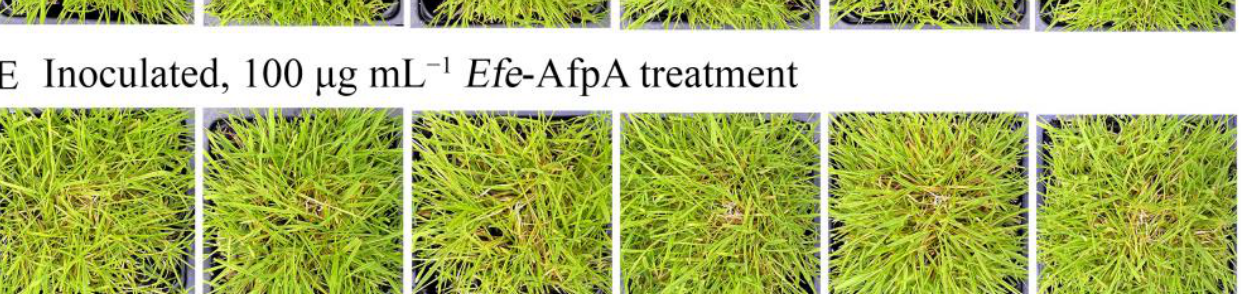
Figure 9. Effect of Efe -AfpA concentration on expression of dollar spot disease symptoms when creeping bentgrass cv. ‘Crenshaw’ plants were inoculated with an 8 mm plug of C. jacksonii . Plants were sprayed daily for 7 days with either water ( A , B ) or different concentrations of Efe -AfpA ( C – E ). Photos within a row are replicates of the labeled treatment.